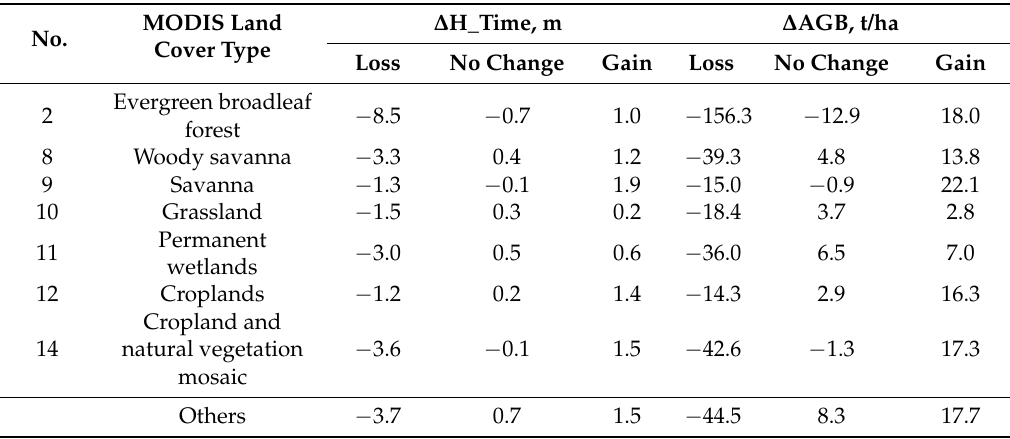
Table 5. Mean height change and corresponding AGB change for combinations of land cover type and Landsat-based gain-loss